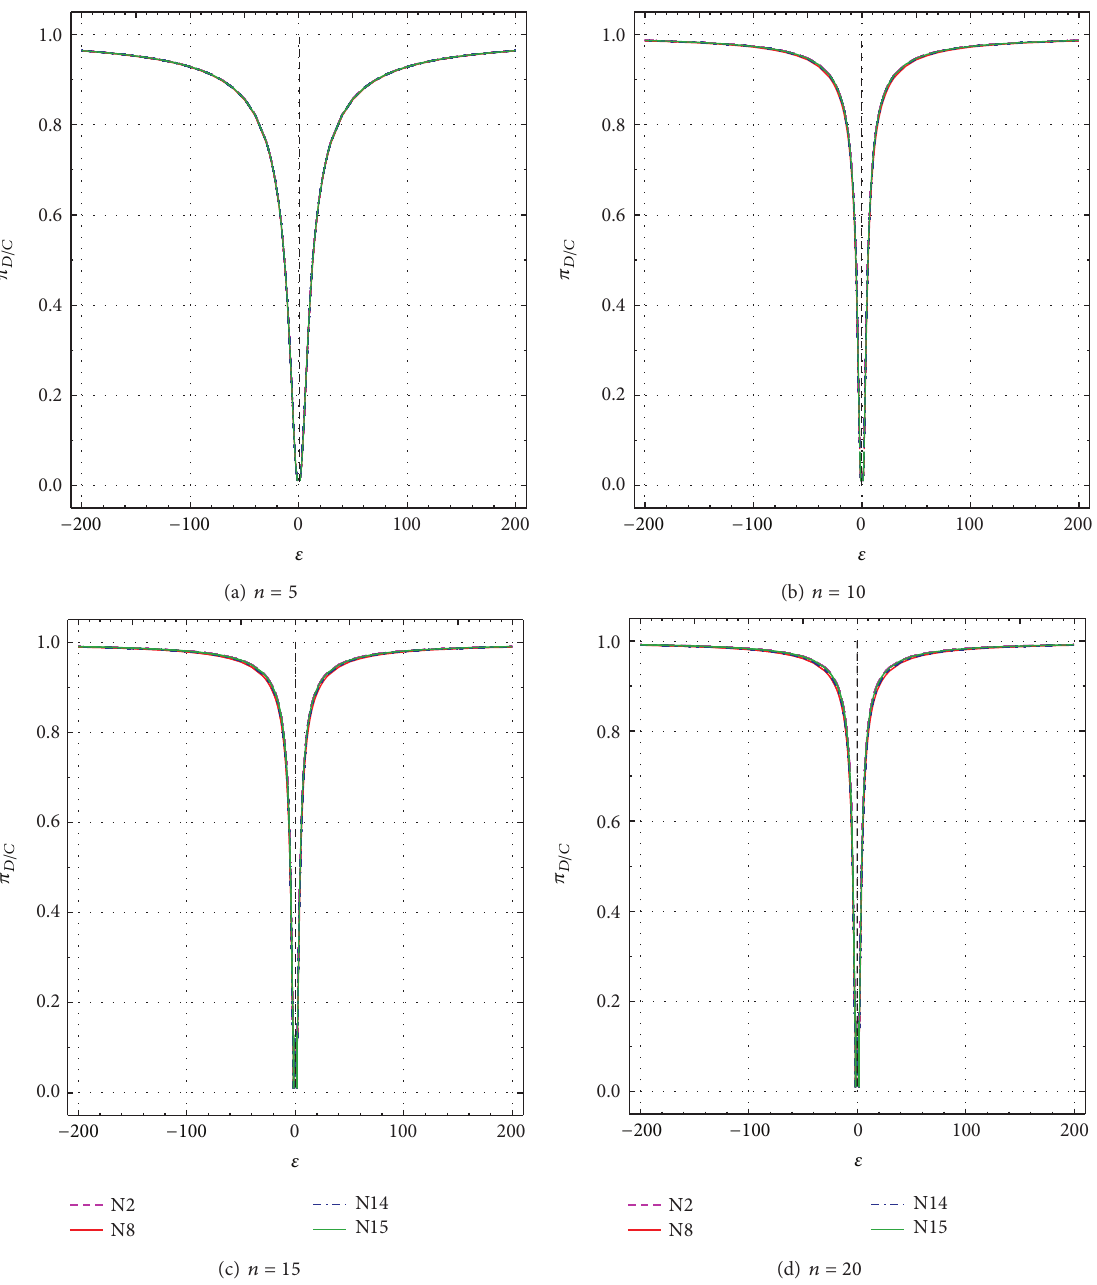
Figure 12: Test Performance Criterion ( 𝜋 𝐷|𝐶 , or Conditional Power P5) as a function of 𝜀 from − 1 to − 200 and +1 to +200 for all tests N2, N8, N14, and N15. (a) 𝑛 = 5 ; (b) 𝑛 = 10 ; (c) 𝑛 = 15 ; and (d) 𝑛 = 20